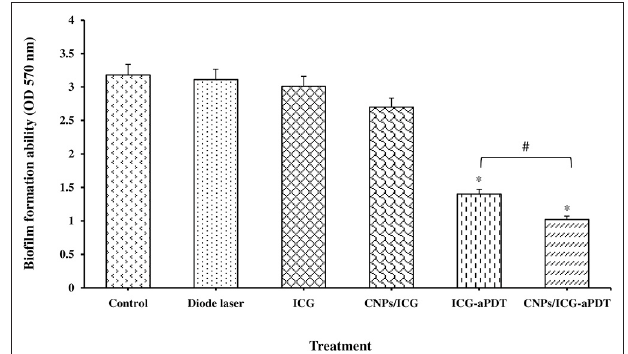
FIGURE 5 | Biofilm formation ability of Aggregatibacter actinomycetemcomitans after exposed with test groups. Results are represented as mean ± standard error of the mean. *Significant difference from control ( P < 0.05). # Significant difference between ICG-aPDT and